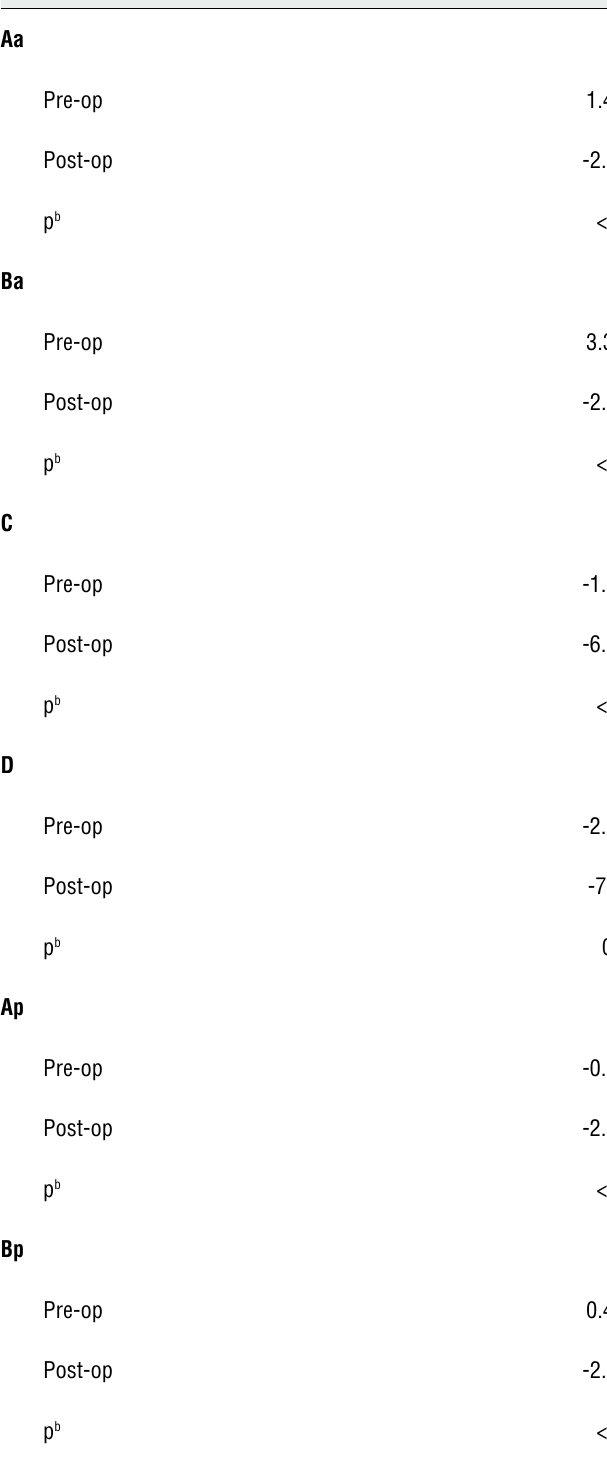
Mesh Control p a